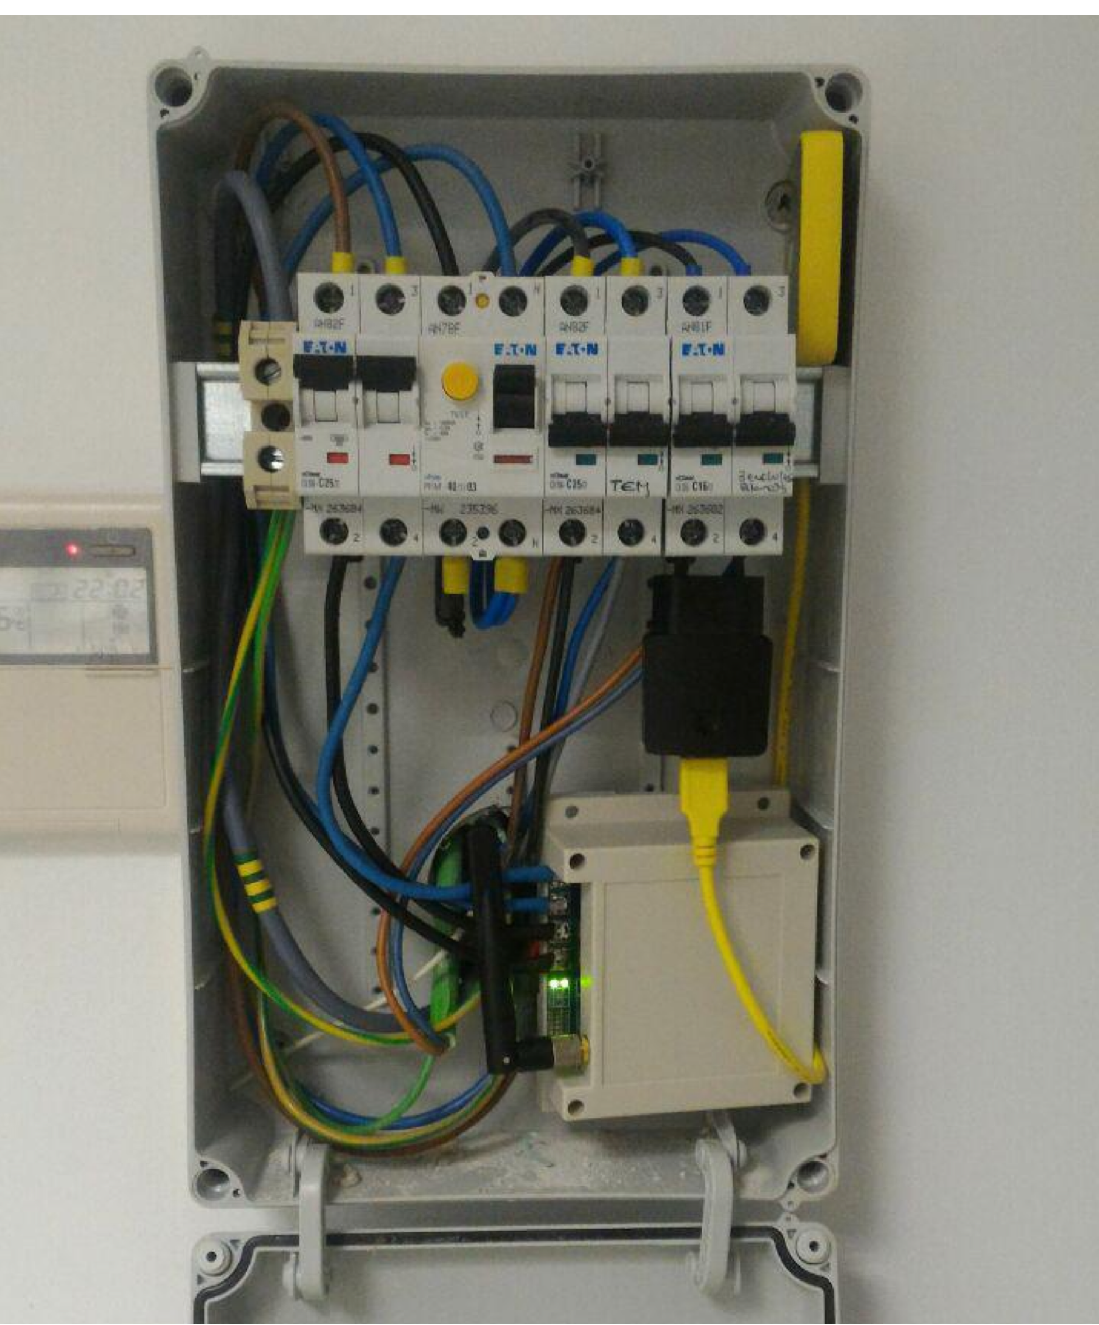
Figure 7. oZm installed in facilities of the University of